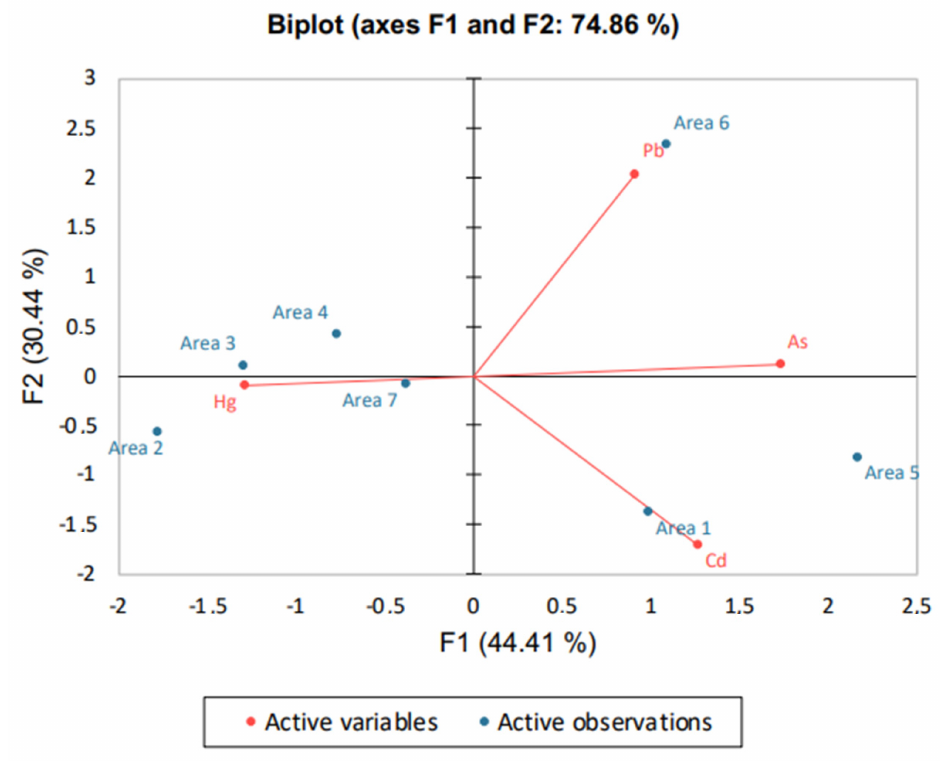
Figure 2. PCA biplot produced for toxic trace elements on